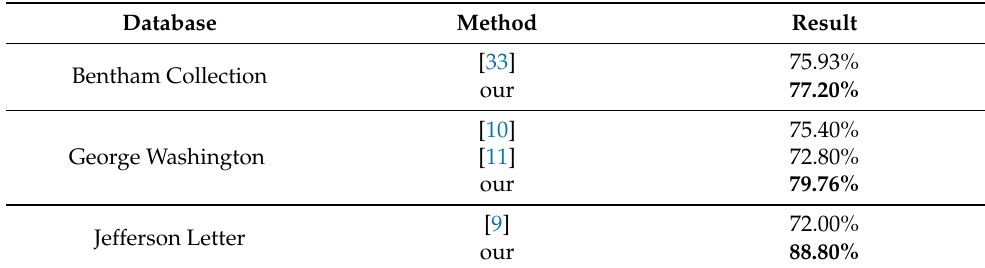
Table 4. Comparison of alignment results with the state of art. The results are given in terms of accuracy. The best results are in